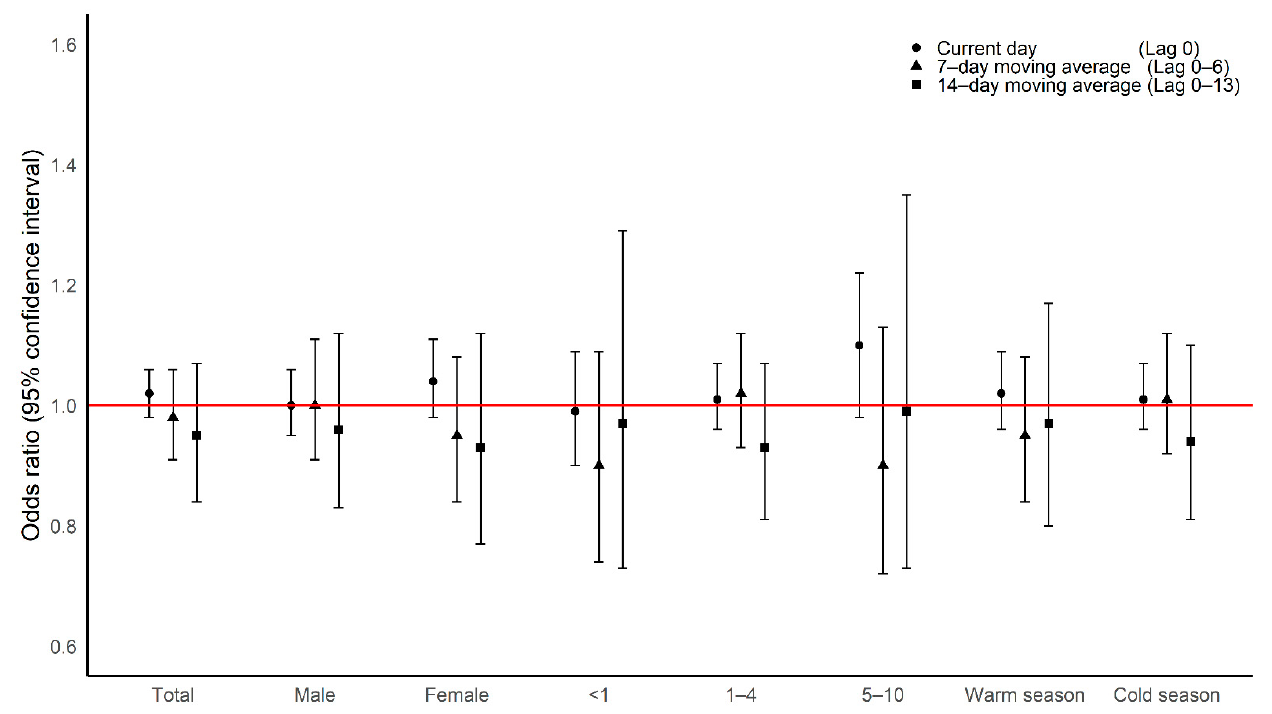
Figure 2. The association between current day, two-, seven- and 14-day moving average exposure to PM 2.5 and children’s KD hospitalizations. The circle shape designates the effect size of the lag 0. The triangle shape indicates the effect size of the lag 0–1. The square shape indicates the effect size of the lag 0–6. The diamond shape shows the effect size of the lag 0–14. The red line demonstrates the borderline. The warm season includes the months of April to September, while the cold season includes October to March. All models were adjusted for daily mean temperature and humidity. The odds ratio was calculated per 10-unit increase.